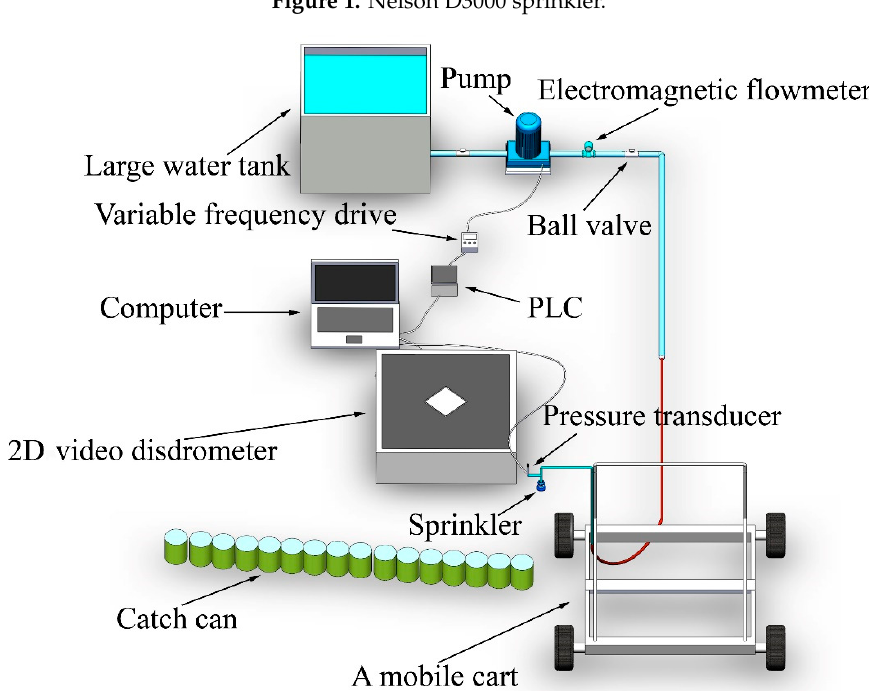
Figure 2. Dynamic water pressure test platform .